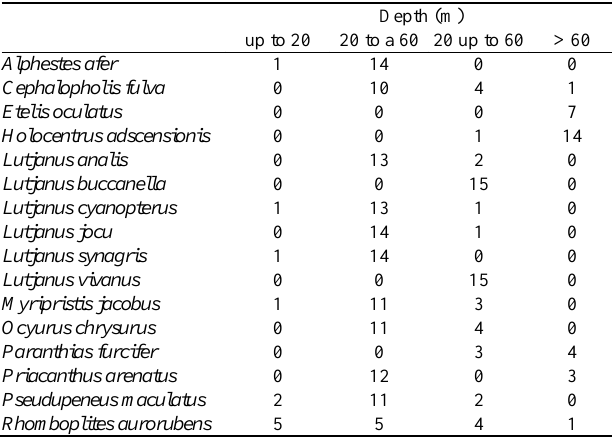
Table 5. Depths inhabited by the snapper group according to interviewees with the respective number of obtained answers (number of interviews = 15; for the E . oculatus and P . furcifer n = 7).